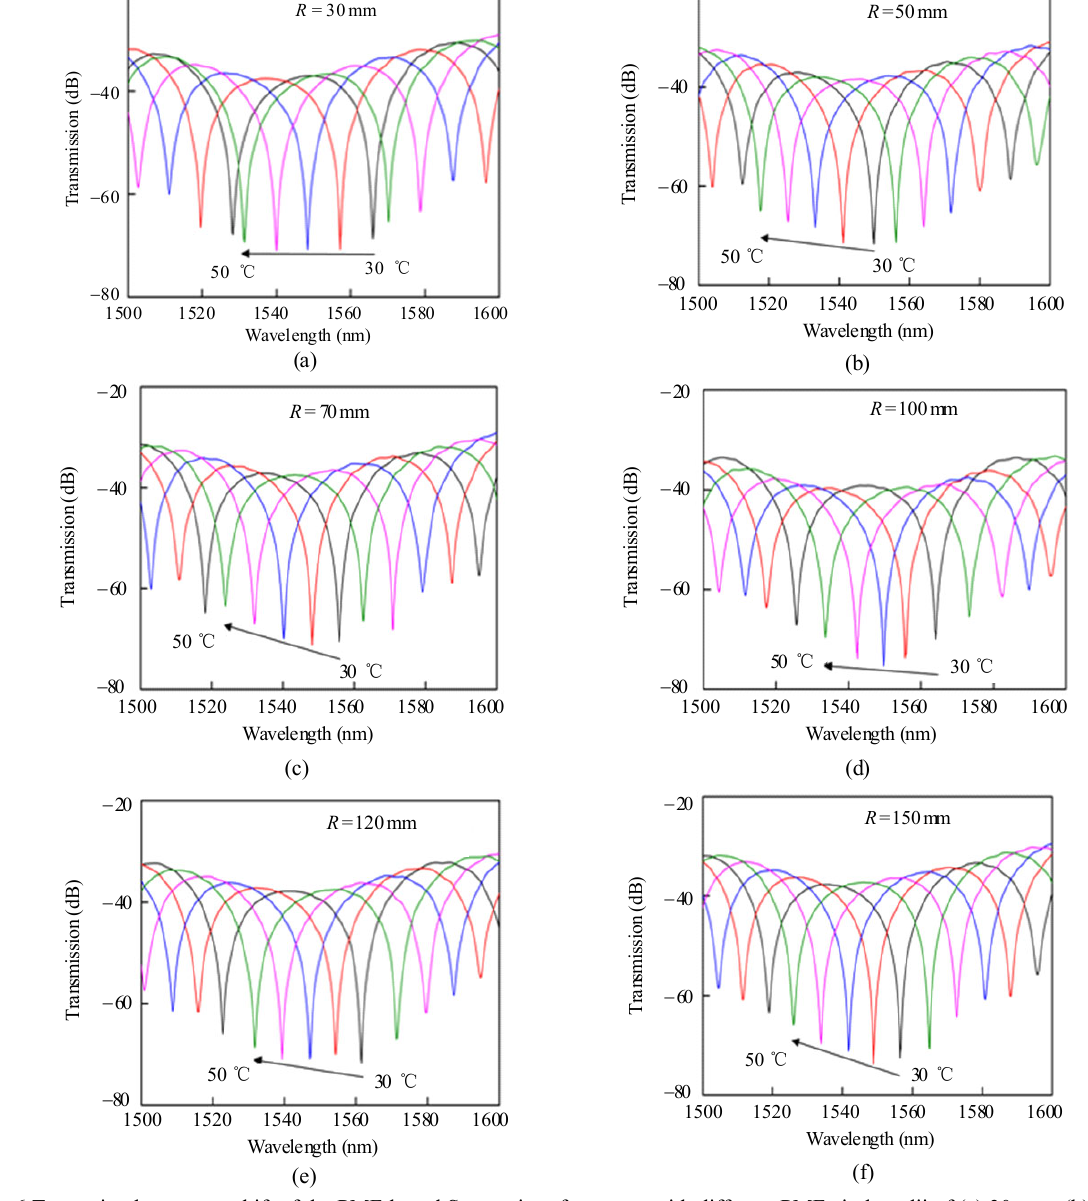
Fig. 6 Transmitted spectrum shift of the PMF-based Sagnac interferometer with different PMF circle radii of (a) 30 mm, (b) 50 mm, (c) 70 mm, (d) 100 mm, (e) 120 mm, and (f) 150 mm at room